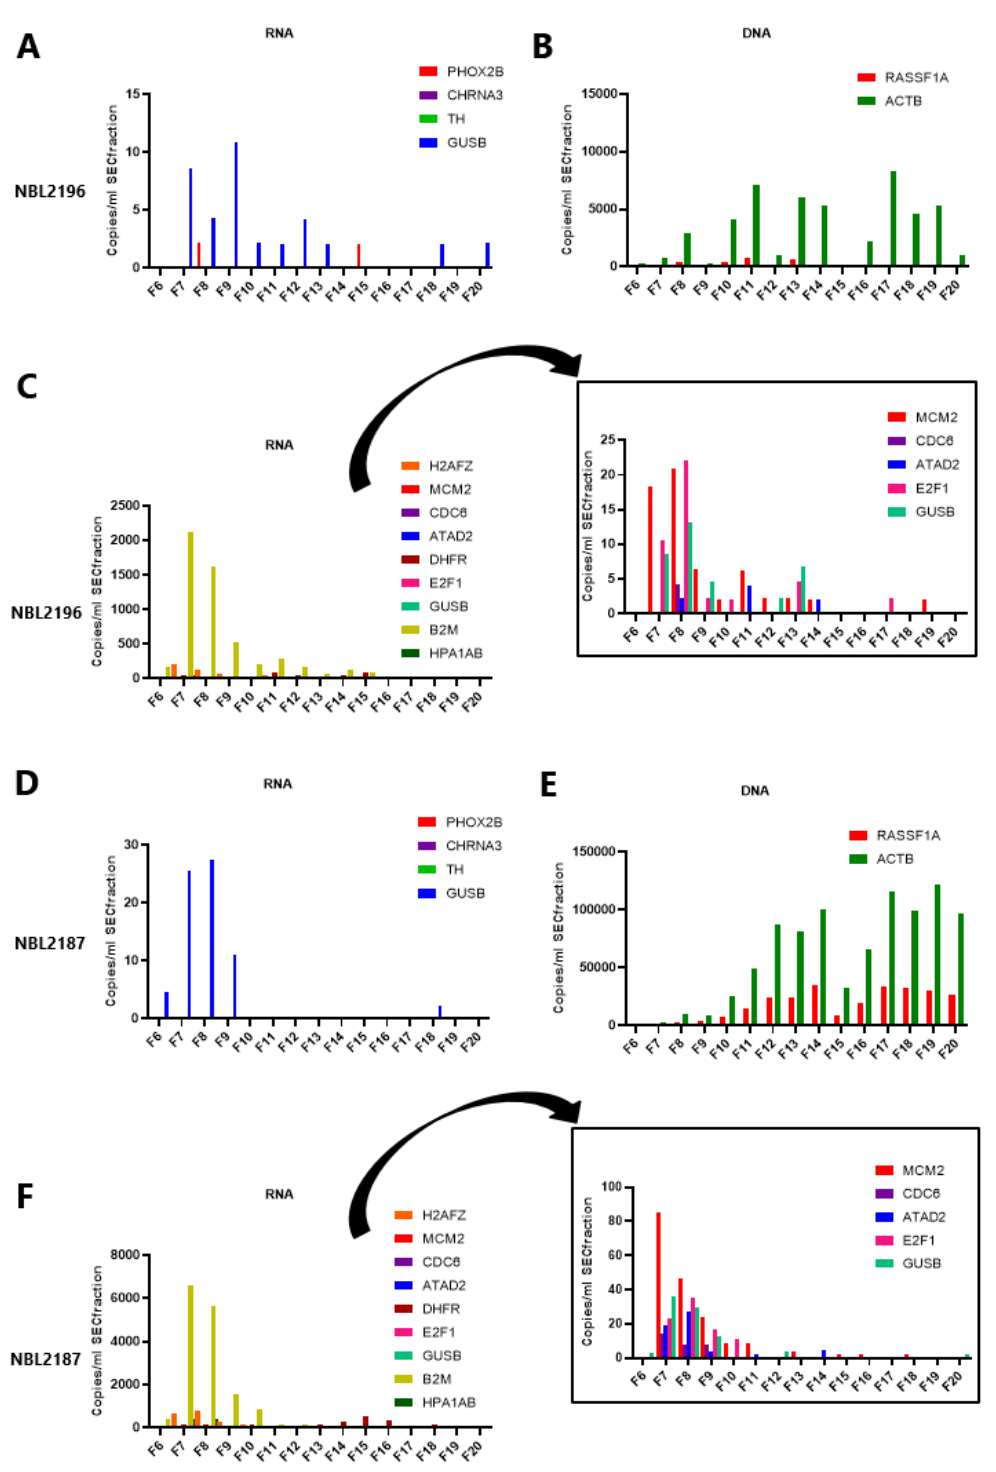
Figure 3. Expression of the mRNA markers and cell-free DNA markers in fractions isolated by size exclusion chromatography (SEC) and analyzed by ddPCR. Fractions F7 to F10 are considered as enriched in extracellular vesicles (EV). For patient NBL2196, ( A ) shows the expression of the neuroblastoma-specific mRNA markers, PHOX2B , CHRNA3 and TH , and reference gene GUSB in cell-free RNA from 200 µ L per SEC fraction: only GUSB and PHOX2B are expressed. ( B ) shows the cfDNA tumor-specific target methylated RASSF1A ( RASSF1A -M) and reference gene ACTB in cfDNA from 200 µ L per SEC fraction. ( C ) illustrates the expression of the cell cycle markers ( H2AFZ , MCM2